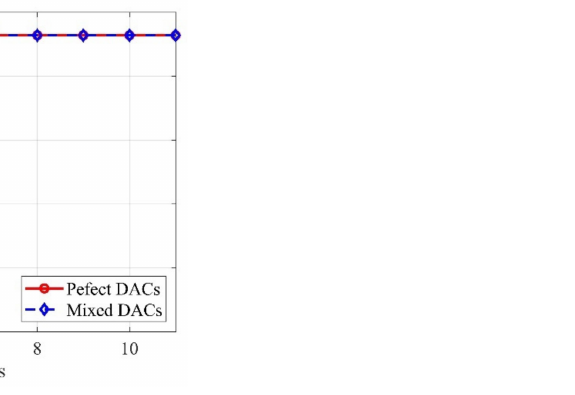
Figure 4. Downlink sum-rate versus the number of bits for different κ , with M = 60, N = 10, K = 10. In Figure 5, the downlink sum-rate versus the κ for different quantization bits is described, with M = 60, N = 10, K = 10. From Figure 5 we see that, for the low-resolution DACs, the downlink sum-rate raises as the κ increases, especially for 1-bit DACs. The reason is that with the increased κ , the proportion of the perfect DACs is raised, and then the downlink rate of the system can be greatly improved.